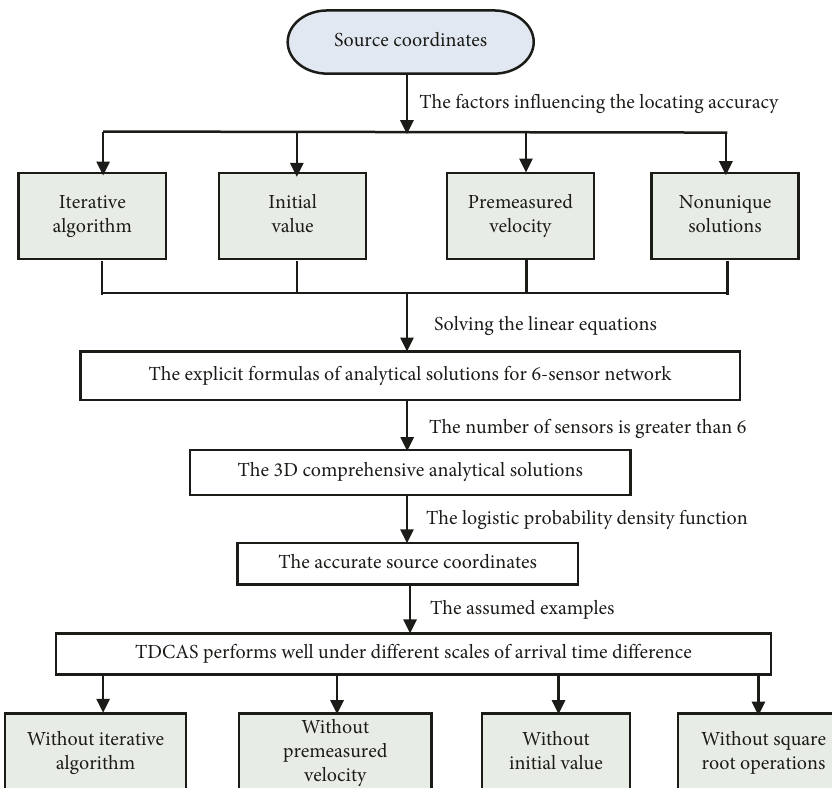
Figure 4: Localization process and advantages of the proposed 3D analytical localization method. To eliminate the effects of the iterative algorithm, initial value, premeasured velocity, and nonunique solutions, a 3D comprehensive analytical localization method was proposed for random sensor networks. The localization processes for 6 sensors networks and random sensor networks are shown above. This method highlights four advantages: without iterative algorithm, without premeasured velocity, without initial value, and without square root